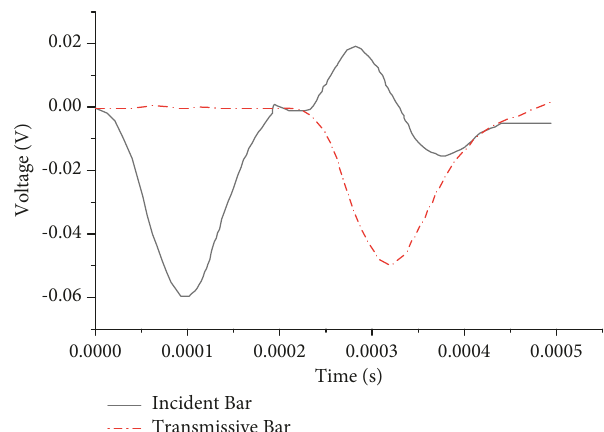
Figure 5: Electrical signal diagram of the typical sample during the experiment. Table 1: Uniaxial impact compression test data. Sample